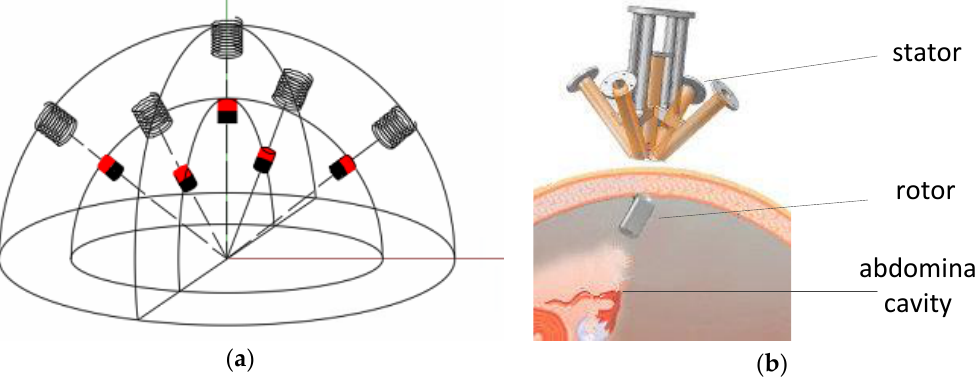
Figure 2. ( a ) shows the distribution of electromagnets in the stator and the IPMs in the rotor; ( b ) shows the working principle diagram of laparoscopic robot.